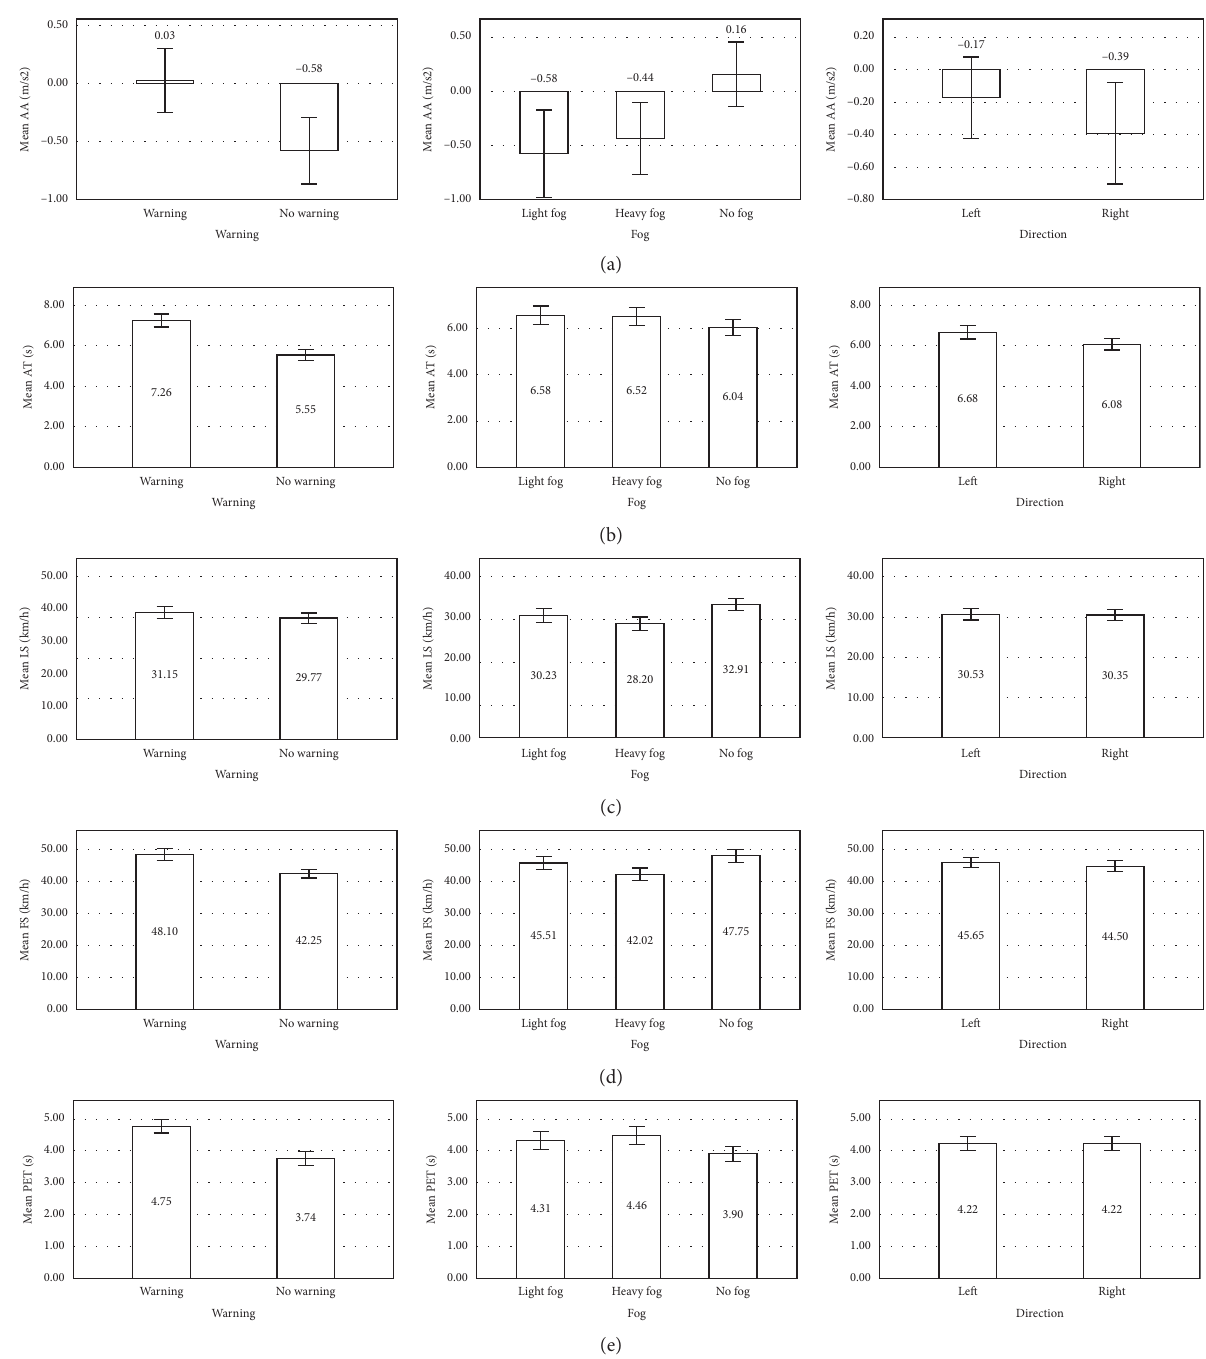
Figure 9: Fitted mean profiles of AA, AT, FS, LS, and PET with respect to different levels of factors. (a) AA; (b) AT; (c) LS; (d) FS; and (e)